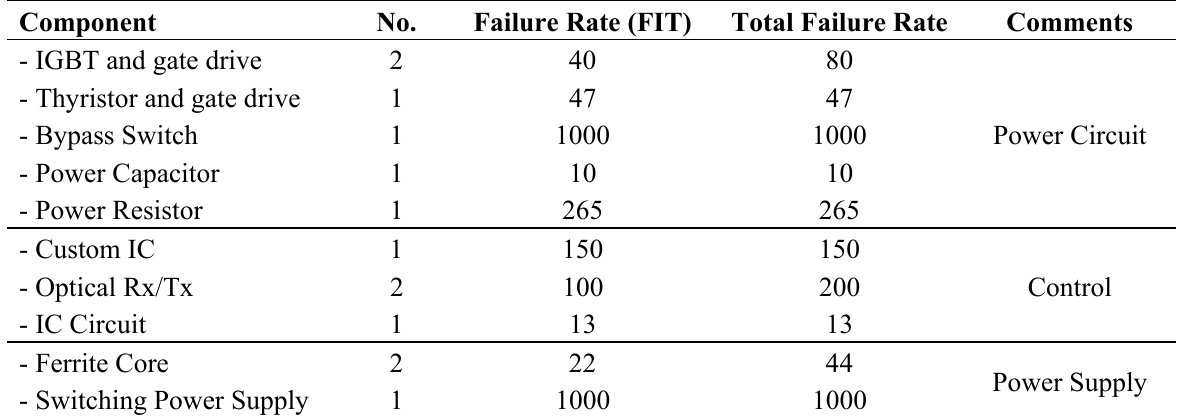
Table 2. Failure Rate